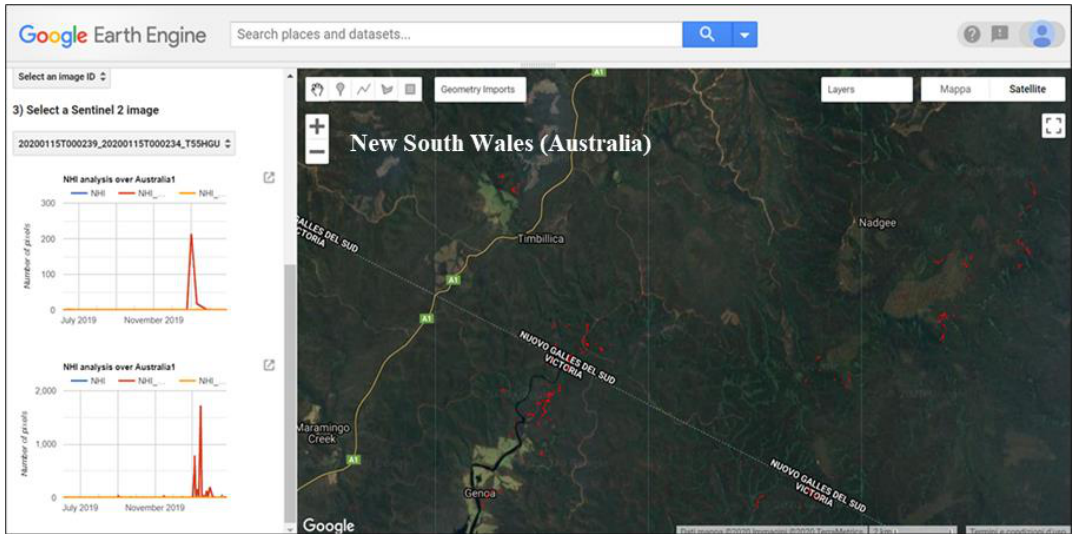
17 of 22 Figure 14: Thermal anomalies (red/yellow pixels) identified by NHI, under the GEE platform, at Val d’Agri (Southern Italy) Oil Center (Basilicata Region; Southern Italy) from Landsat -8 OLI data of 14 December 2019.